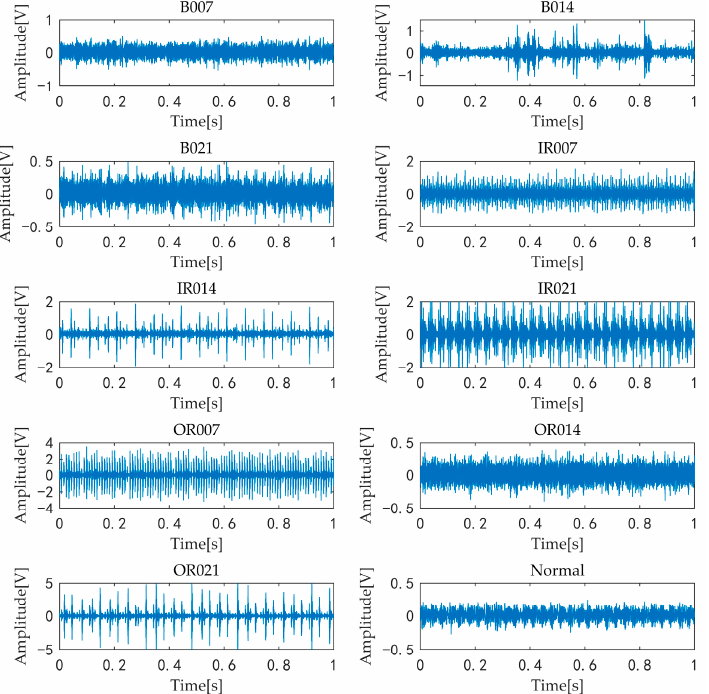
Figure 5. Original vibration signal time-domain waveforms of the drive-end rolling bearing under the 0–3 hp load.